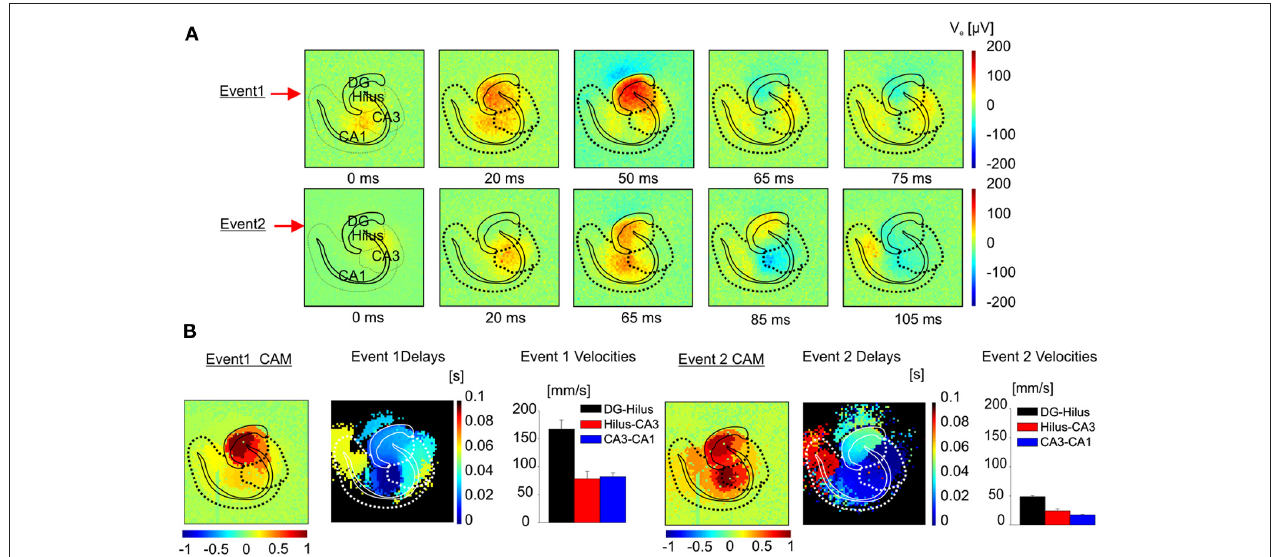
FIGURE 10 | Classification algorithmappliedtoI-ICs in thehippocampus. (A) Color-coded map of extracellular voltage showing the propagation of two different I-IC events. (B) For the two events in (A) the CAM, the maps of the delays and speeds of propagation e.g., from dentate gyrus to hilus (black bars),